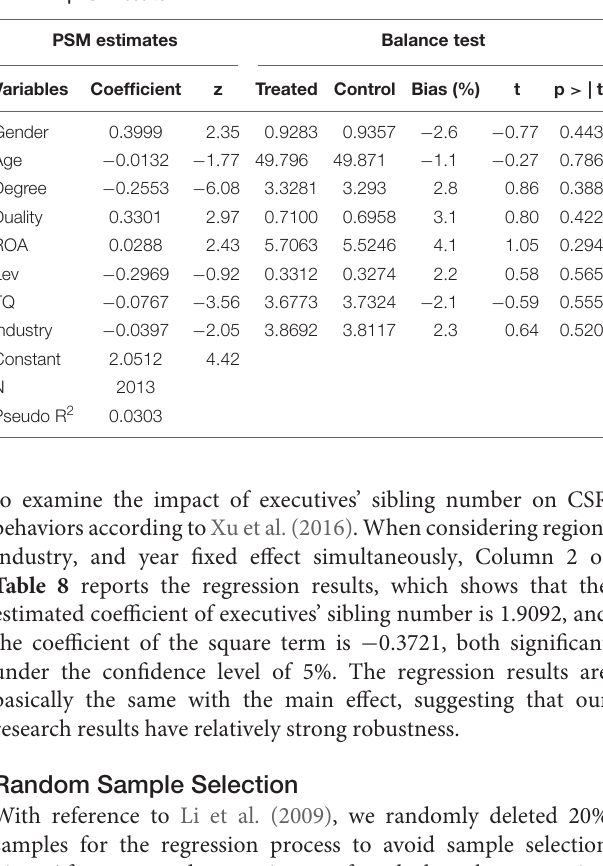
TABLE 7 | PSM results. TABLE 8 | Robust test